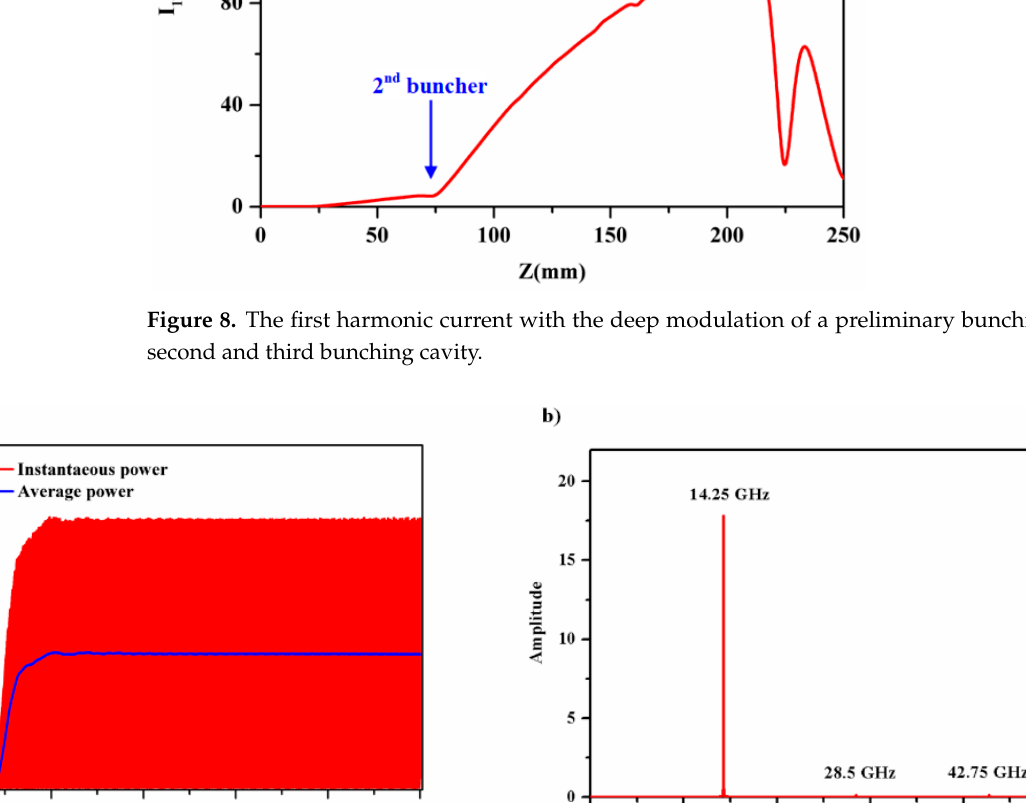
Figure 10. The first harmonic current distribution versus electron beam voltage and current. Figure 11. The efficiency and gain versus electron beam voltage.